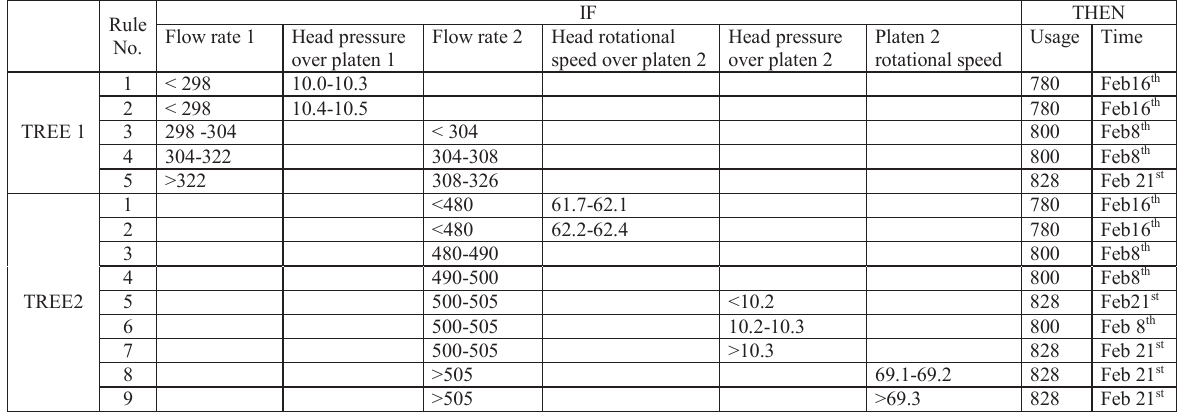
Table 4. Decision Rules for Stage 2